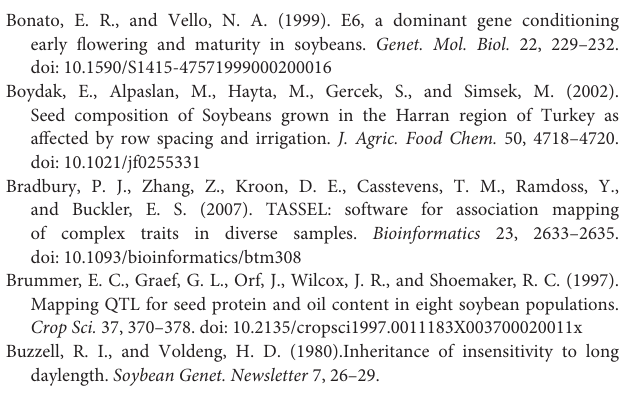
Figure S3 | GWAS of flowering time (R1) in the northern geographic region using FarmCPU. Manhattan plots (bottom) and Quantile-quantile (upper right) plot for a trait. Negative log10 P-values from a genome-wide scan are plotted against SNP positions of 20 chromosomes. The horizontal dash line indicates the significant